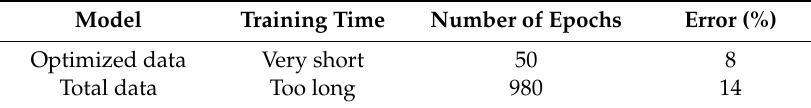
Table 2. Simulation ANFIS model based on optimized data vs. total data.